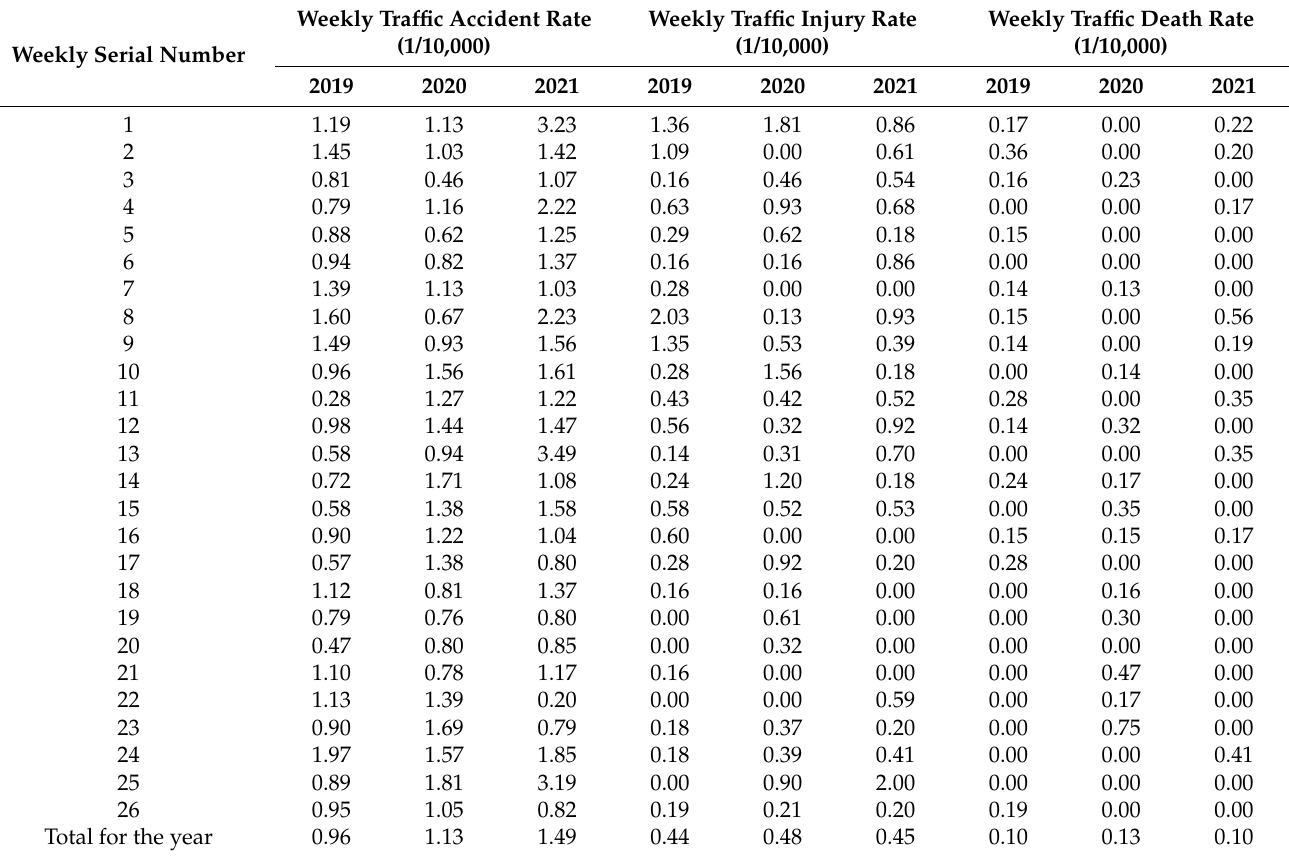
Table 7. The calculation results of the NPTHN accident rate and casualty rate.